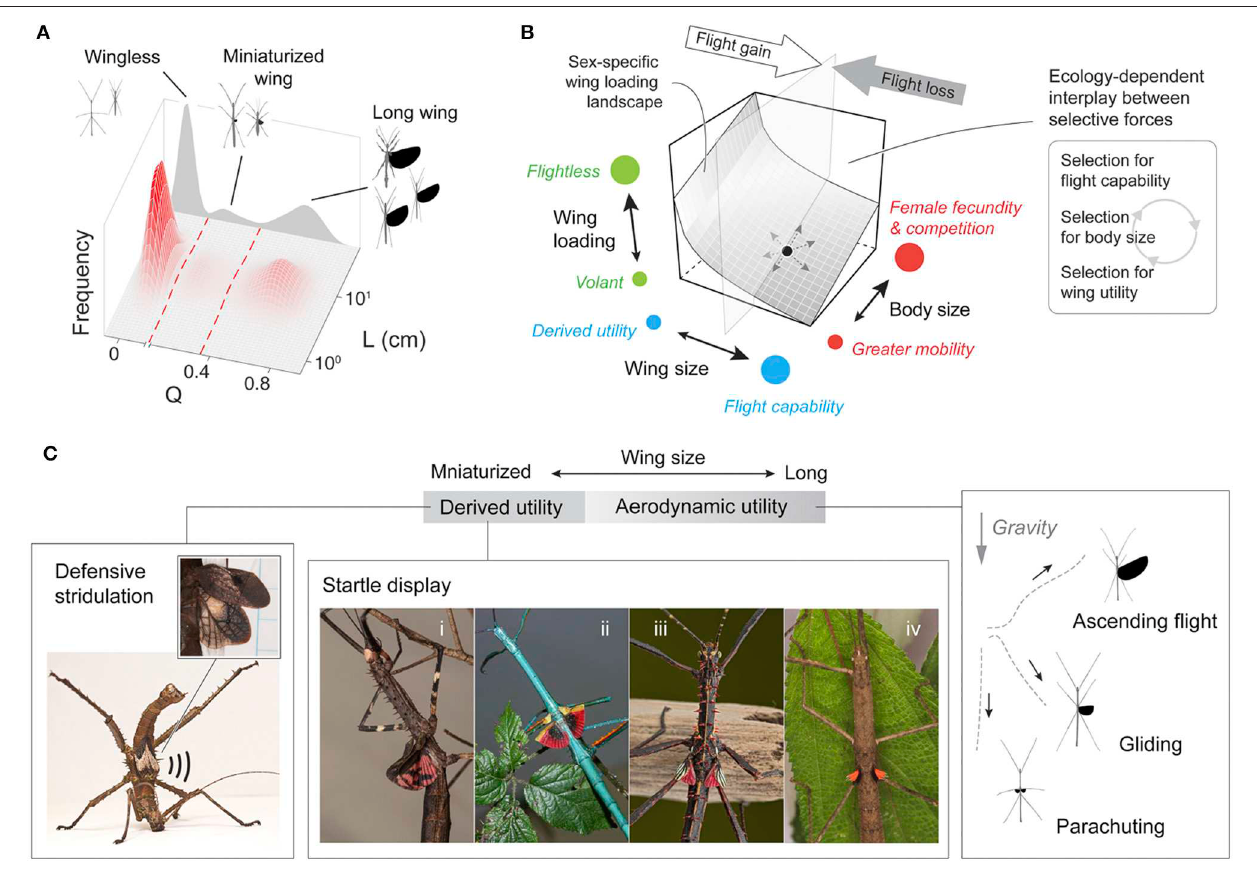
FIGURE 8 | A summary of evolution of flight-related morphology in stick insects. (A) Relative occurrence of different flight morphologies with respect to a feature space defined by Q and L ( Figure 3 ), indicating three main peaks corresponding to wingless, miniaturized-wing, and long-wing morphologies. (B) Schematic demonstration showing that the evolution of flight morphology (for any given position on the wing loading landscape) is driven by the interplay between three major forces and tradeoffs (inset). (C) Variation of wing utility with respect to relative wing size. Continuous variation in aerodynamic performance is coupled with the full spectrum of relative wing size variation, whereas derived functions such as use in startle displays or stridulation are frequently found in miniaturized wings. Examples of startle display: (i), Diesbachia hellotis female; (ii), Achrioptera manga male; (iii), Parectatosoma cf. hystrix male; (iv) Oxyartes dorsalis female [Photos of (i)—(iii) courtesy of Bruno Kneubühler]. Example of defensive stridulation: Haaniella echinata male.